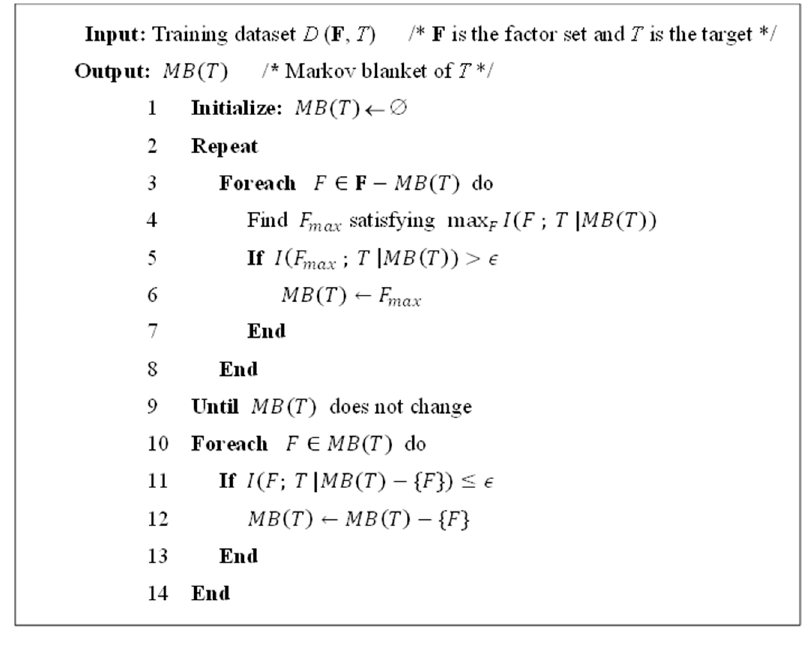
Figure 2. IAMB algorithm.